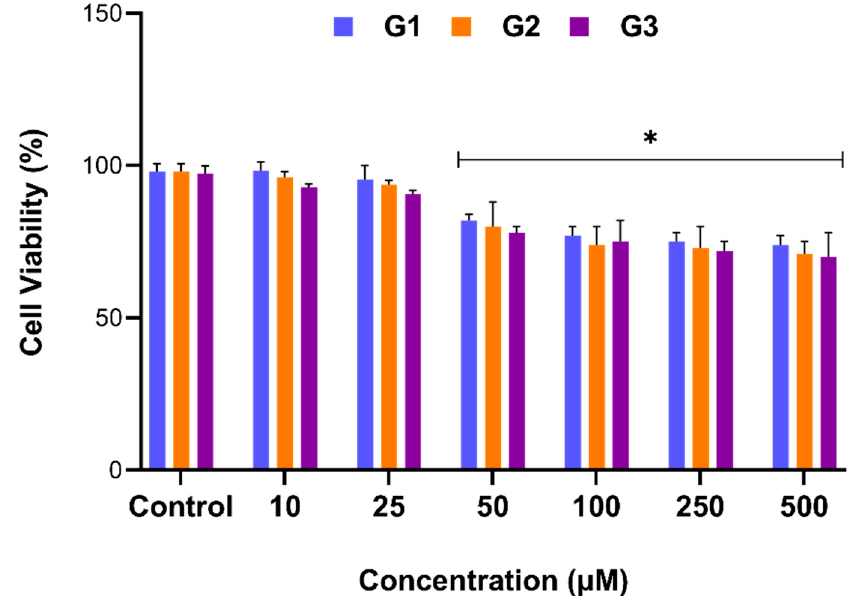
Figure 3. Determination of cytotoxicity of PAMAM-conjugated di-n-dodecylamine micelles (DL-G1, DL-G2, DL-G3). AGS cells were treated with DL-G1, DL-G2, and DL-G3 micelles alone (without 5FU) for 24 h, and cell viability was assessed by WST-1 assay. Data were presented as the percentage of cell viability relative to the control group of each generation. Error bars represent the standard deviation of the mean (* p < 0.05).